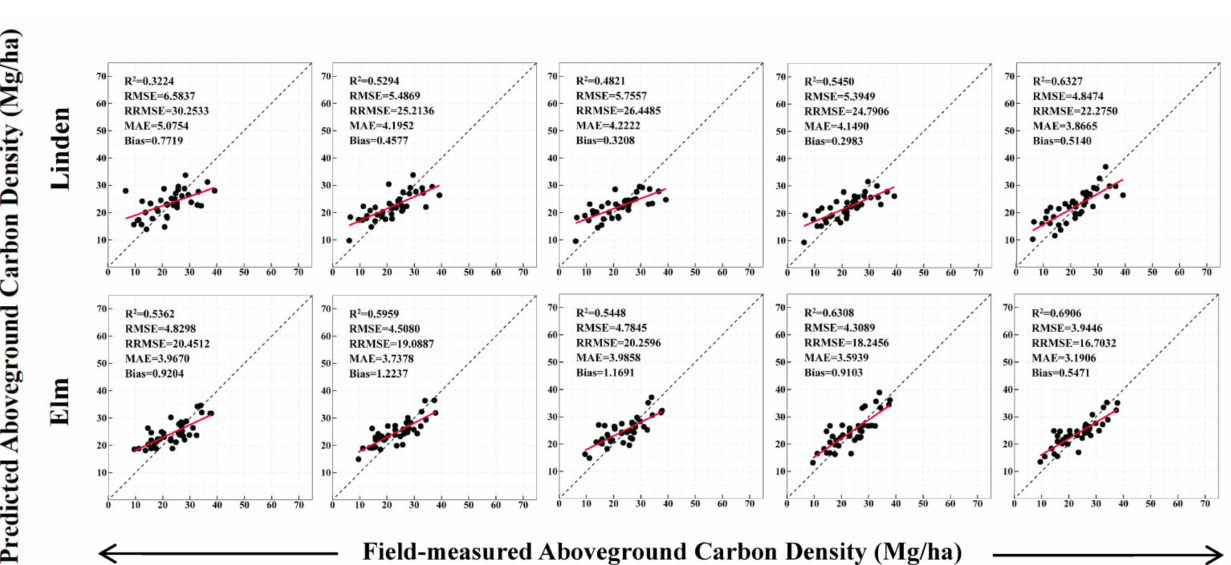
Figure 6. Model estimation accuracy evaluation results based on the validation datasets using stepwise regression and four ML algorithms in eight different dominant species.